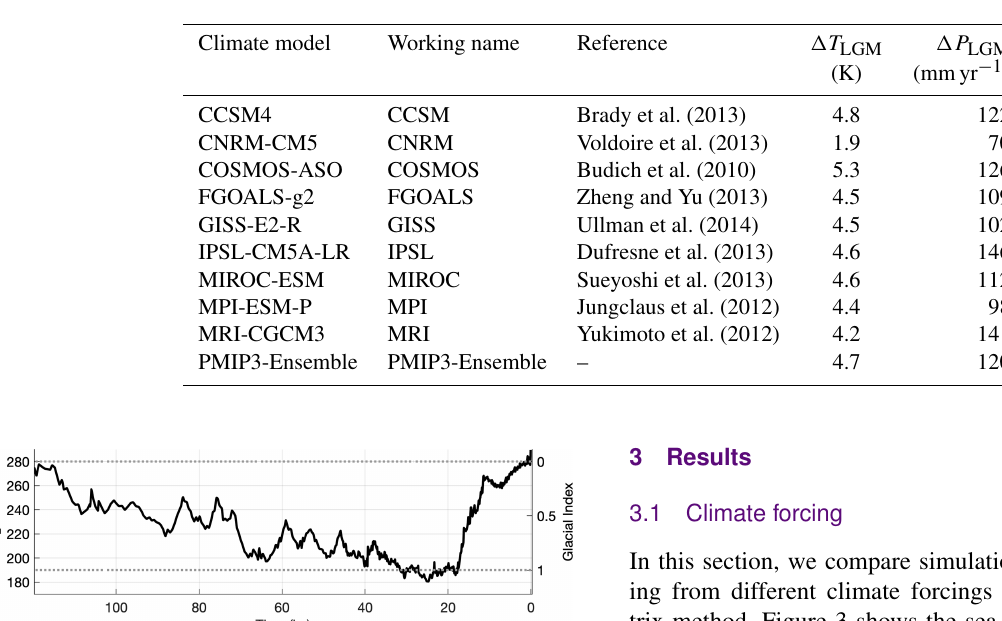
Table 1. The climate forcing from PMIP3 model output that was used in this study. PMIP3-Ensemble represents the mean of COSMOS, IPSL, MIROC, and MPI. The global annual temperature ( T ) and precipitation ( P ) difference between the LGM and PI is shown for each climate model.